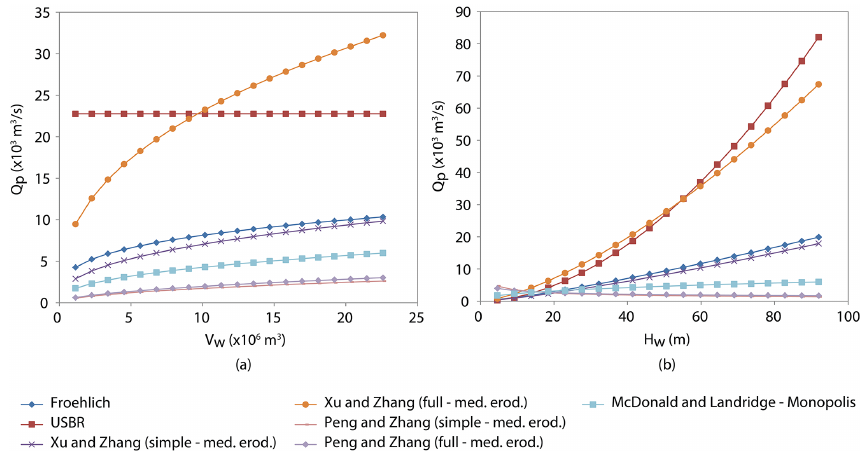
Figure 8. Peak flow response to (a) water volume variations, and (b) water depth variations according to selected empirical